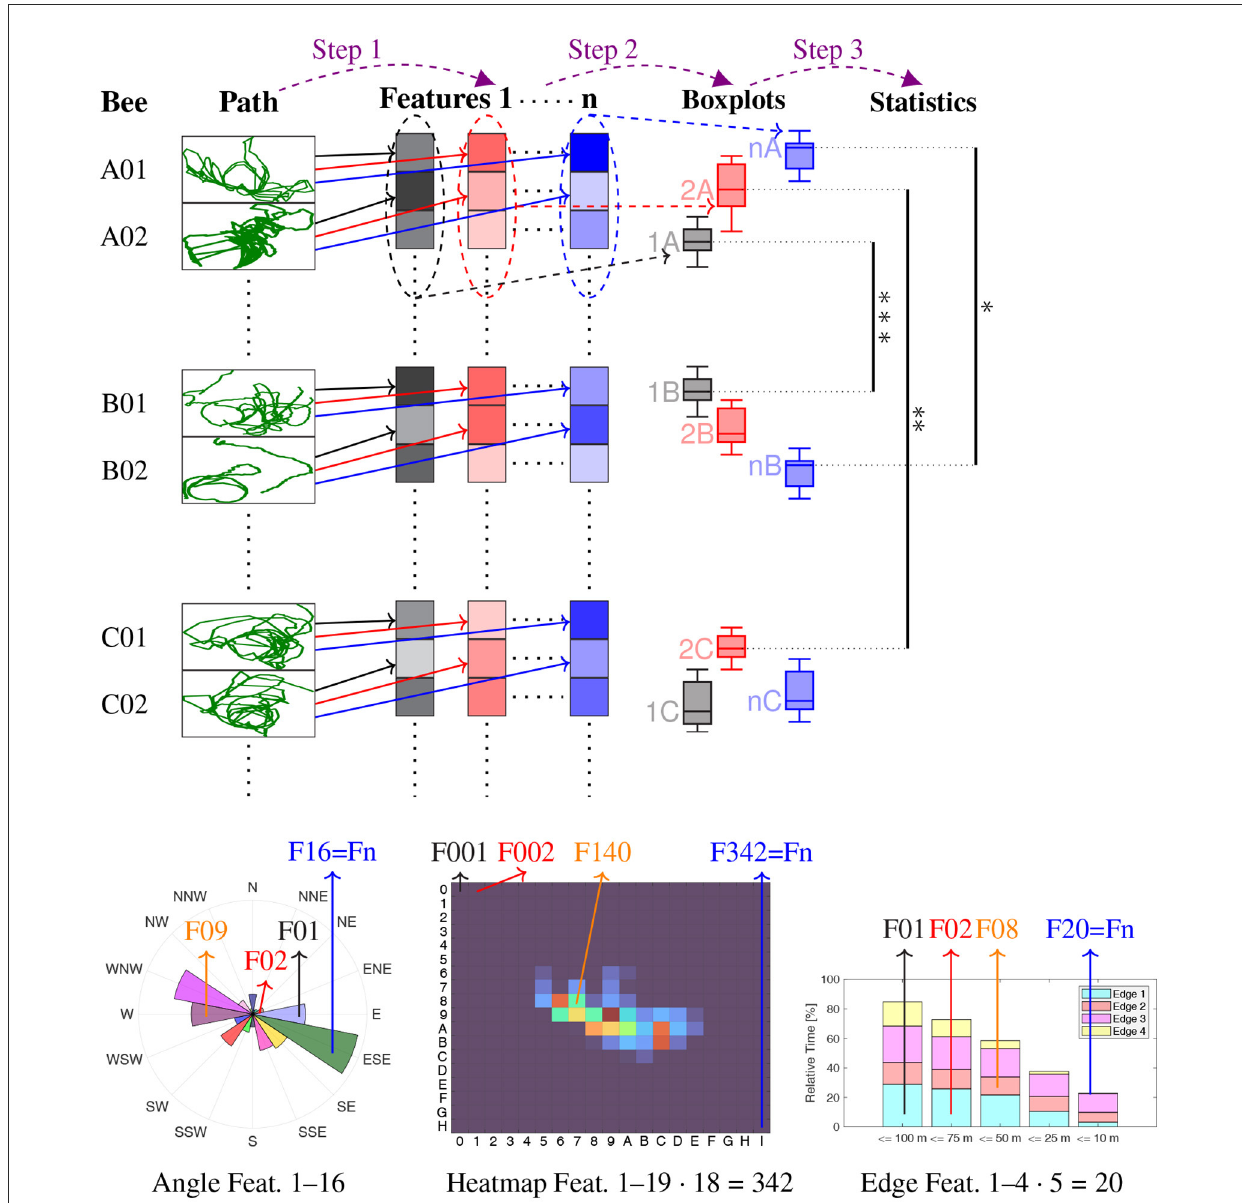
FIGURE2 Illustration of the analysis procedure. Step 1: The flight path of each bee is used to calculate a number of features (the black, red and blue boxes), compressed in vertical direction for illustration purposes. These features are Directional analysis Relative time spent in each of 16 cardinal directions, n relative to the release site 16 features, Heatmap analysis Relative time spent in 19 → = Heatmap analysis with PLS Partial least square projections of the 342 heatmap